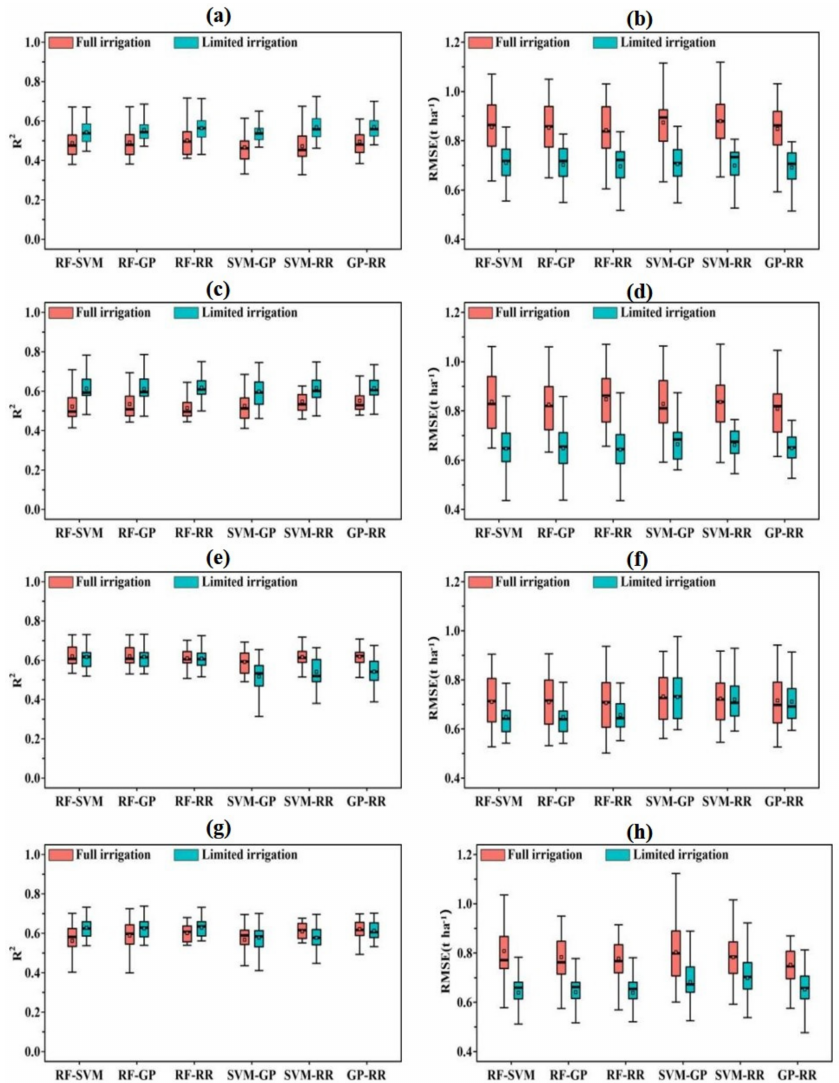
Figure 7. The statistical distributions of prediction accuracy of the stacking regression when including two base learners for predicting grain yield in the test phases; ( a ) distributions of R 2 in the heading stage; ( b ) distributions of RMSE at the heading stage; ( c ) distributions of R 2 in the flowering stage; ( d ) distributions of RMSE at the flowering stage; ( e ) distributions of R 2 in the early grain filling stage; ( f ) distributions of RMSE at the early grain filling stage; ( g ) distributions of R 2 at the mid-grain filling stage; ( h ) distributions of RMSE at mid-grain filling stage. Abbreviations: RF, random forest; SVM; support vector machine; GP, Gaussian process; and RR, ridge